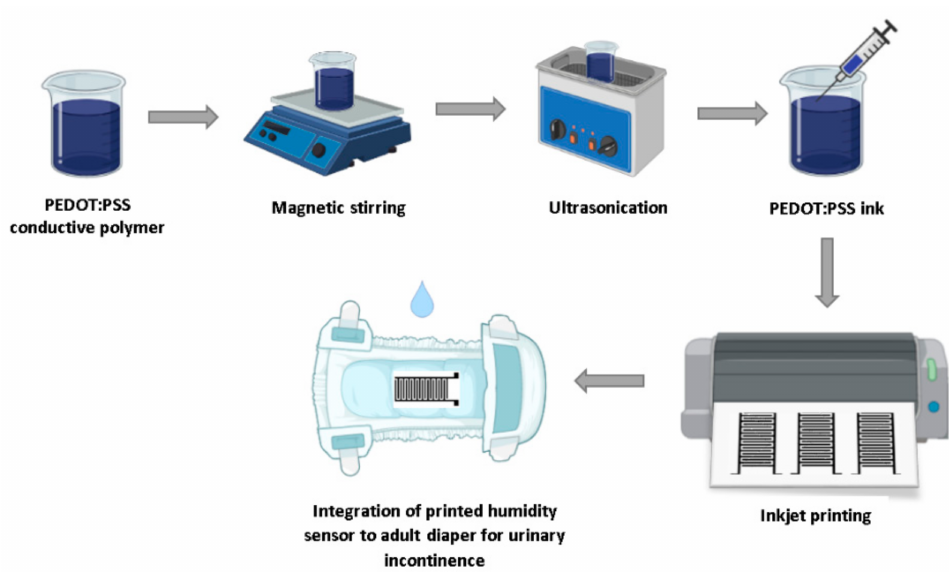
Figure 1. Schematic view of inkjet-printed humidity sensor fabrication, and integration into an adult